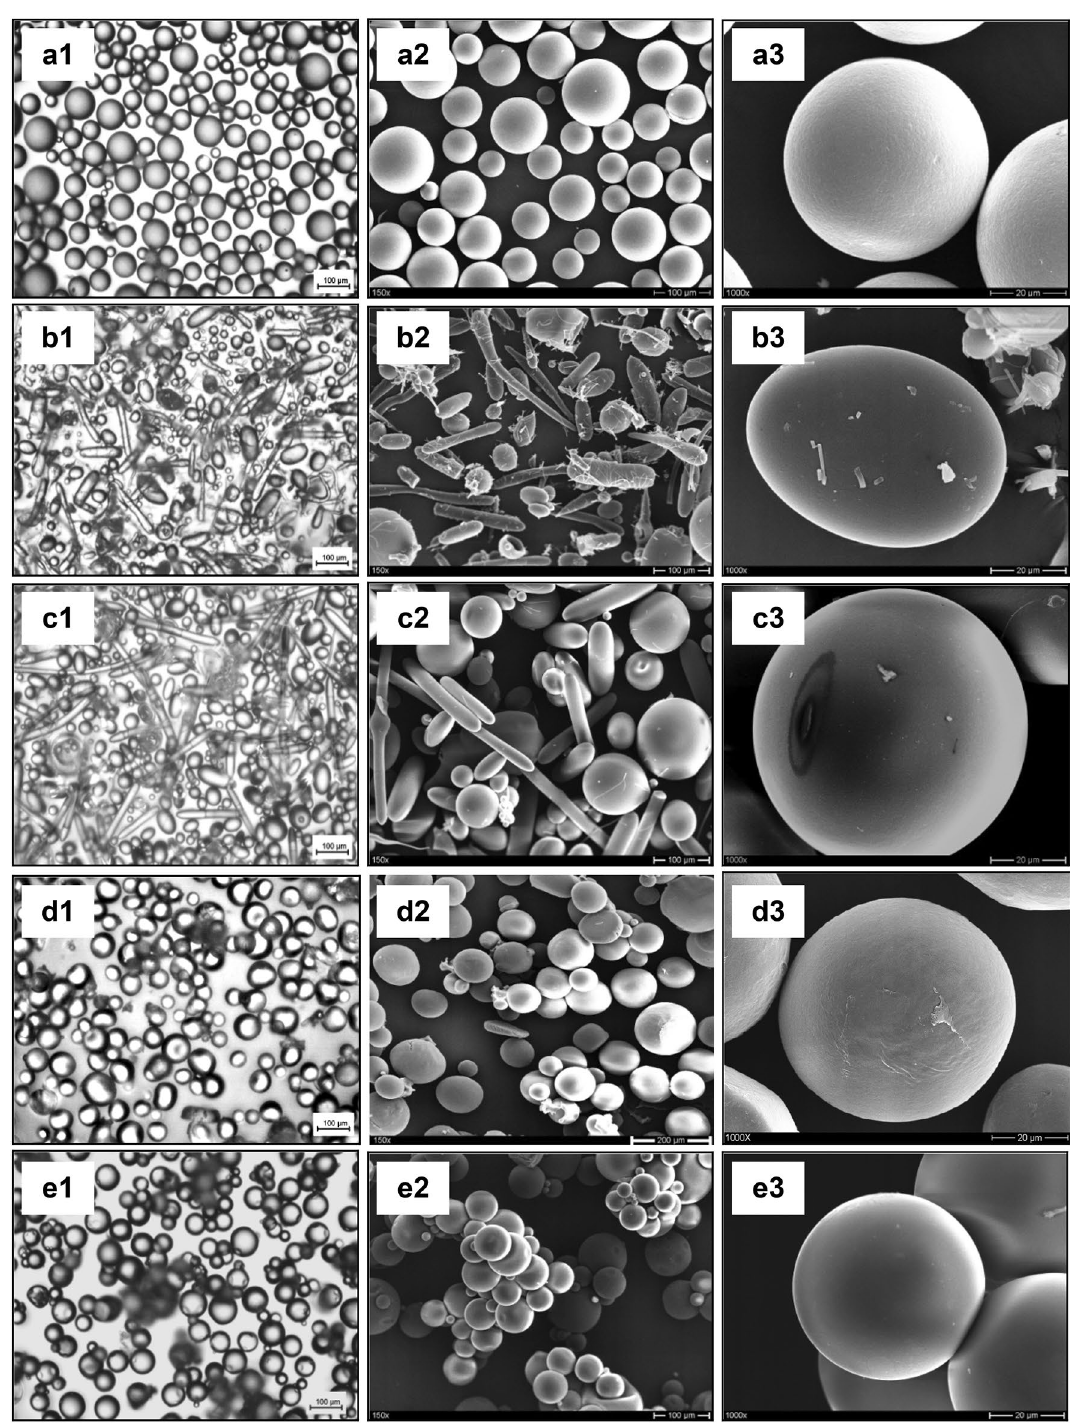
Figure 5. Optical microscopy pictures (1) and SEM pictures of polymeric microparticles (2. at 150 × magnification & 3. at 1000 × magnification) ( a ) Ethyl cellulose 4 cp; ( b ) Eudragit RL 100; ( c ) Eudragit RS 100; ( d ) Polycaprolactone (Mw. 10,000); ( e ) PLGA